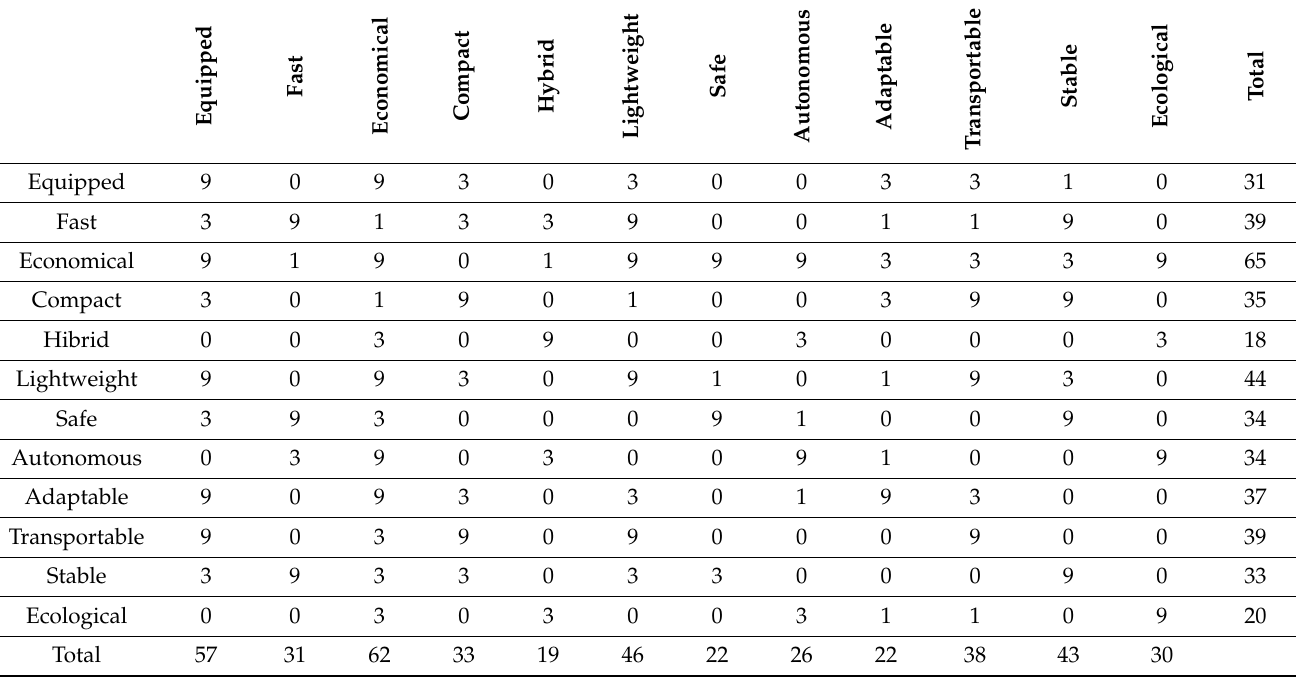
Table 2. Matrix of